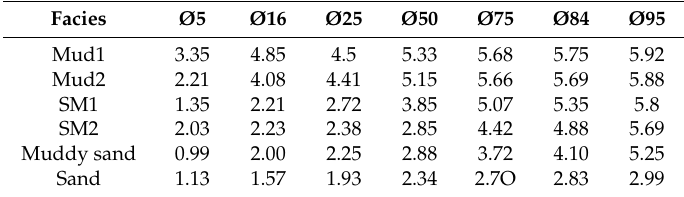
Table 3. Percentile mean values used for grain size parameter calculation.